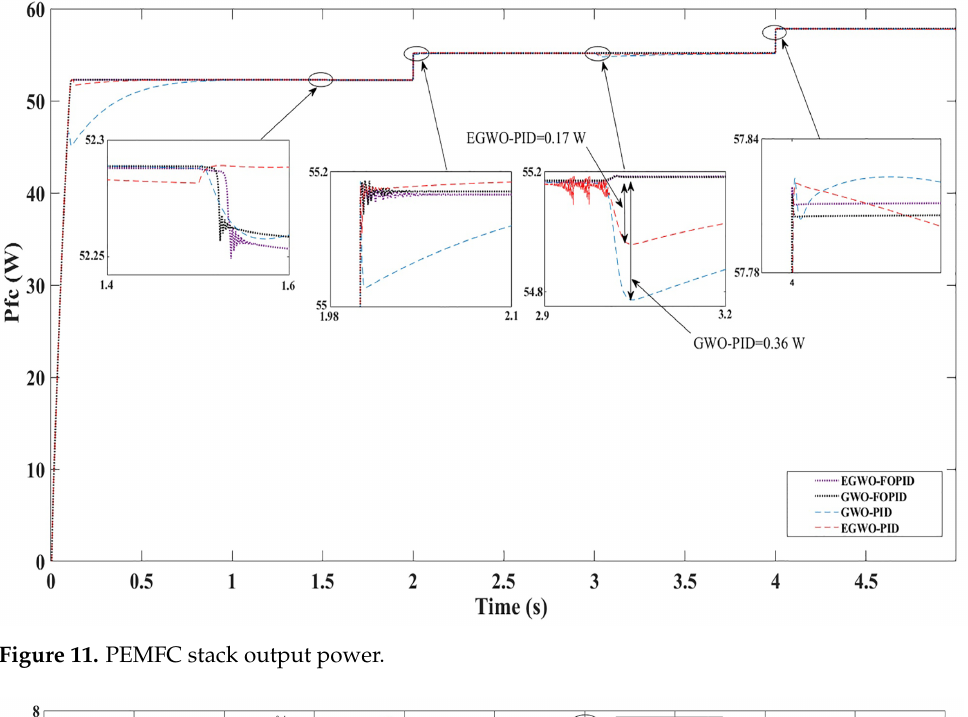
Figure 11. PEMFC stack output power.